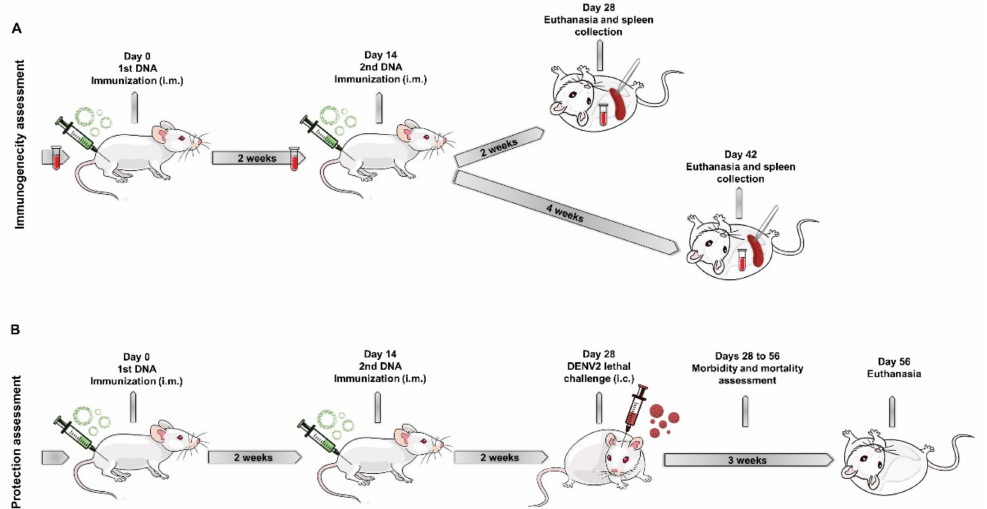
Figure 1. Schematic timeline representation of the in vivo experiments . BALB/c mice were inoculated twice in the tibialis muscle with the DNA vaccines. Immunogenicity tests ( A ) were conducted with blood and splenocytes. Blood was collected prior to immunization, before the second DNA dose and 2 or 4 weeks after the second dose, for antibody analysis. The spleen was harvested 2 or 4 weeks after the second DNA dose to analyze the cellular immune response. For protection tests, immunized animals were challenged intracerebrally with a lethal dose of a neuroadapted DENV2. Mortality and morbidity rates were recorded daily for 3 weeks after challenge ( B